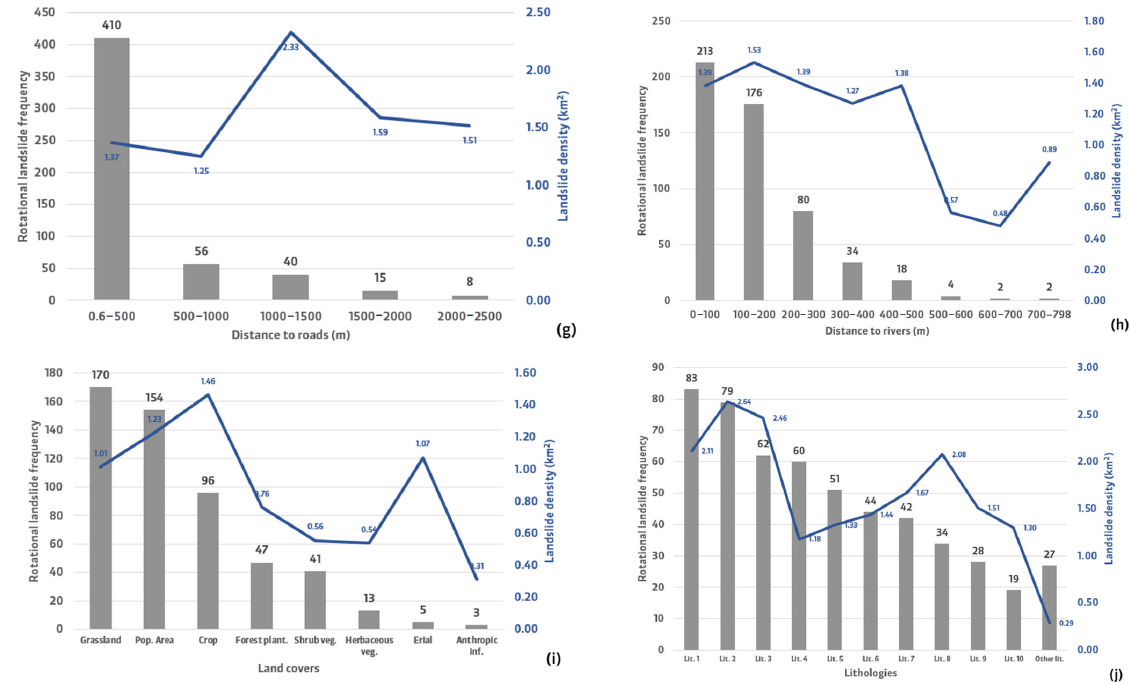
Figure 6. Relation of conditioning factors and rotational landslides in study area: ( a ) elevation, ( b ) slope, ( c ) aspect, ( d ) SPI, ( e ) TWI, ( f ) curvature, ( g ) distance to roads, ( h ) distance to rivers, ( i ) land cover, and ( j ) lithology (lithologies: Lit. 1—coarse andesitic conglomerates; Lit. 2—light laminated